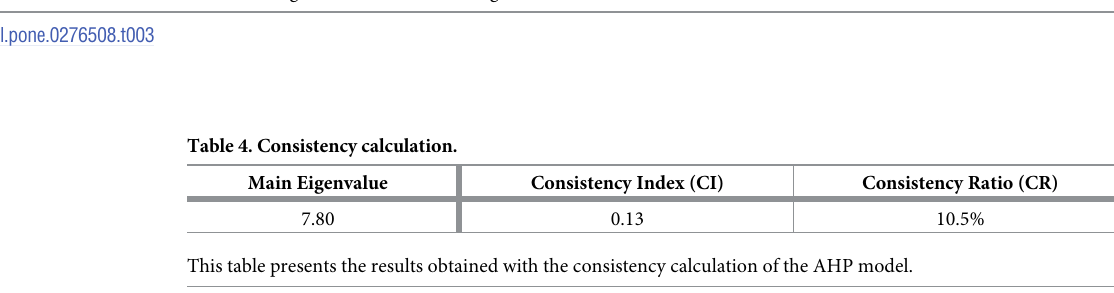
Table 5 only 10 of 1010 alternatives of the model are expressed, where each alternative is equiv- alent to a patient with its physical and clinical characteristics. Initially, the thresholds for applying ELECTRE II were defined, being c + = 0.90, c 0 = 0.80, c − = 0.75, d + = 0.20 and d − = 0.10. Then, the method was run to obtain the concordance and discordance indices according to the performances of the alternatives on the defined criteria. After this, the distillation process was performed to obtain the descending and ascending pre- orders. Finally, the average of the positions was obtained for each alternative, considering the different pre-orders, in order to obtain the final ranking. The positions associated with the final ordering of the alternatives are presented in Table 5.